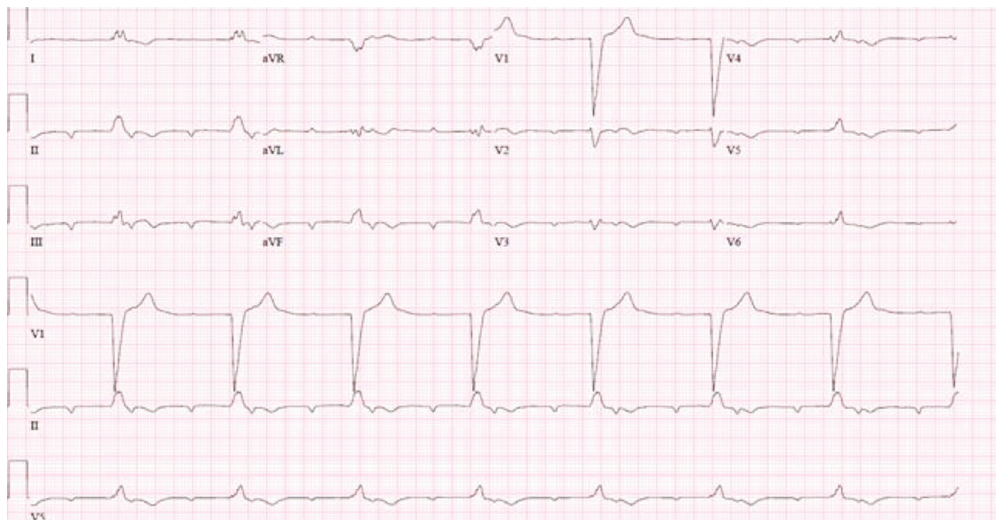
Figure 4: 12-lead EKG showing complete heart block.